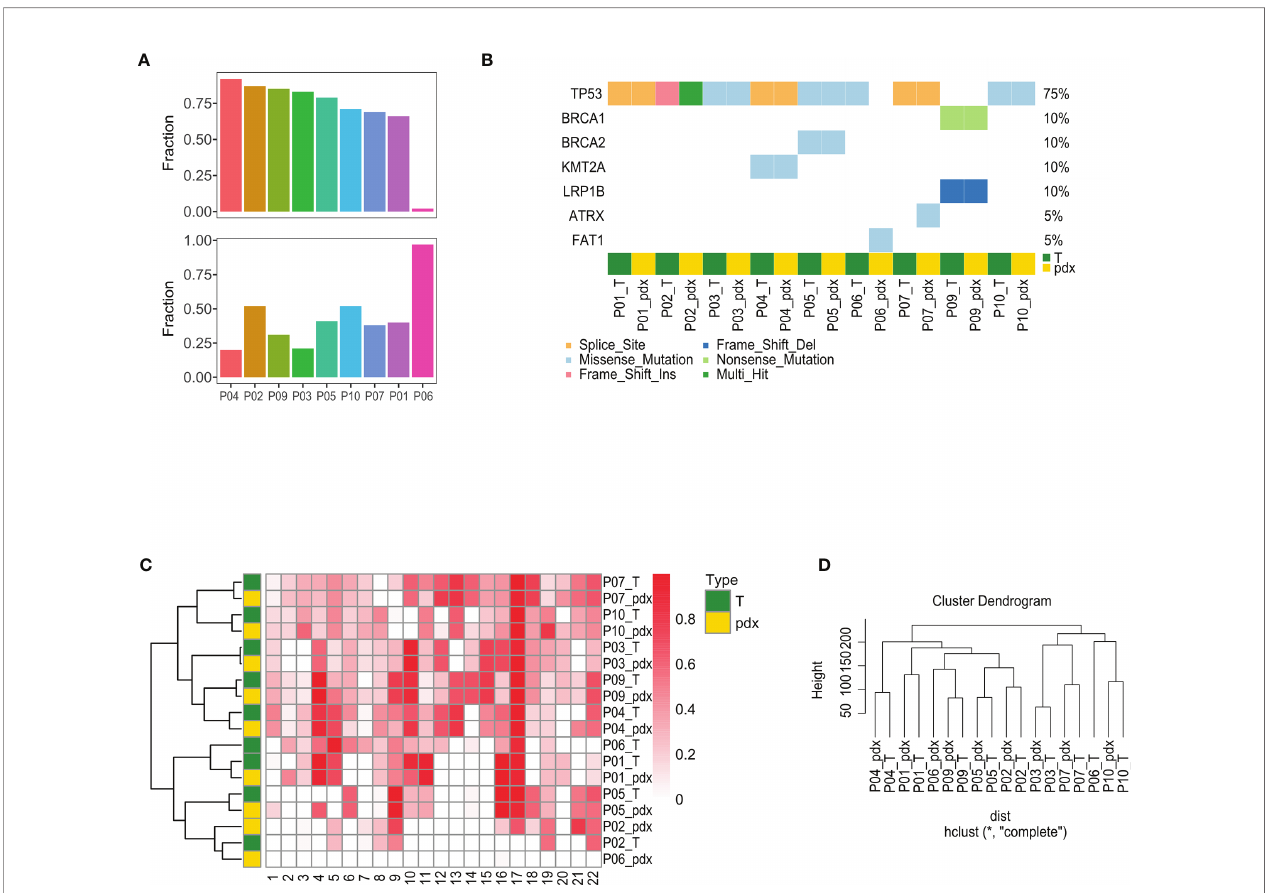
FIGURE 3 | Comparison of mutational features between PA and PDX tumors. (A) This fi gure summarizes the mutation calling results of PA and PDX samples, highlighting the variant classi fi cation distributions within a sample type, SNV class, variants per sample, and the most mutated genes. (B) Within SMG identi fi ed in a pair of PA and PDX tumors, approximately half are shared by both samples, except the paired samples of patient #59. (C) Top SMGs (red square) are demonstrated in 10 pairs of PA and PDX tumors. (D) This heat map shows the LOH proportion on each chromosome (numbered at the bottom) in each sample. Darker red square represents a higher frequency of LOH. PA and the corresponding PDX tumors have a similar LOH pattern. PA, patient tumor; PDX, patient-derived xenograft; SNV, single-nucleotide variant; SMG, signi fi cantly mutated gene; LOH, loss of